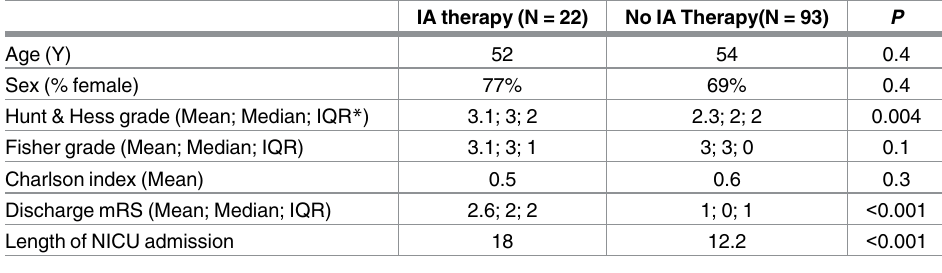
Table 1. Comparison between the Patient